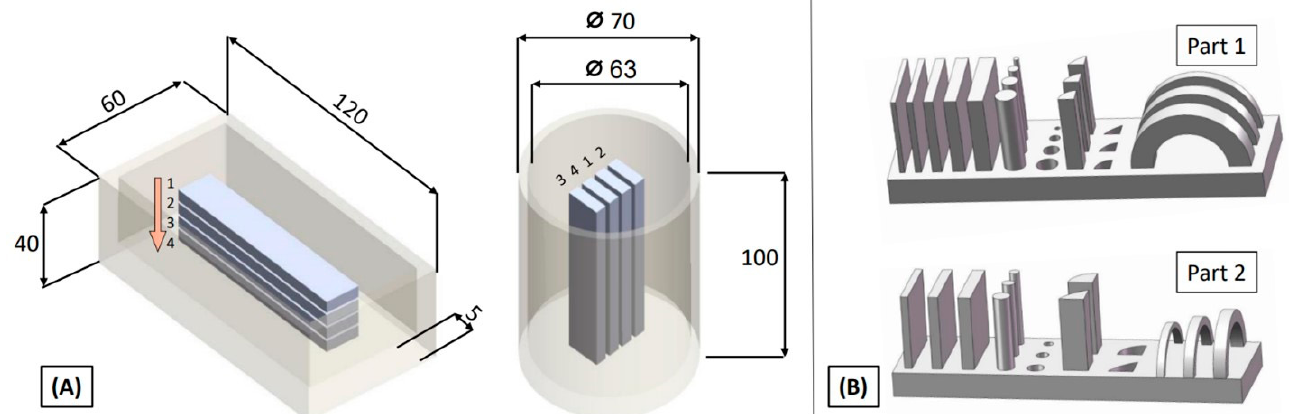
Figure 2. Overview of produced parts. ( A ) Scheme of the positioning of specimens inside the two types of crucibles. The numbering sequence is defined for the position of each specimen within a batch. Horizontally built specimens in parallelepiped crucibles (on the left) and vertically built specimens in cylindrical crucibles (on the right), where dimensions are in mm. ( B ) Test parts produced.